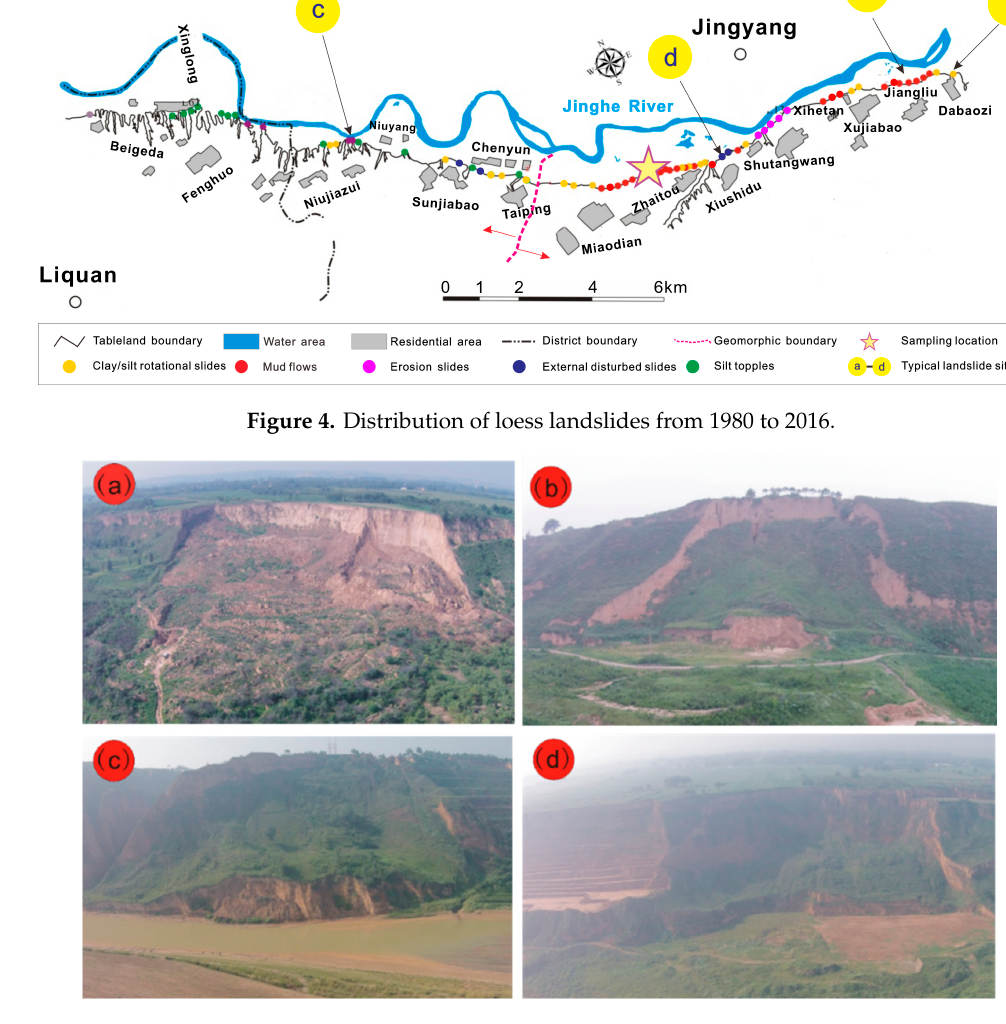
Figure 5. Typical types of loess landslides on the South Jingyang Plateau: ( a ) Mudflow, ( b ) clay/silt rotational slides , ( c ) erosion slide, and ( d ) external disturbed slide.